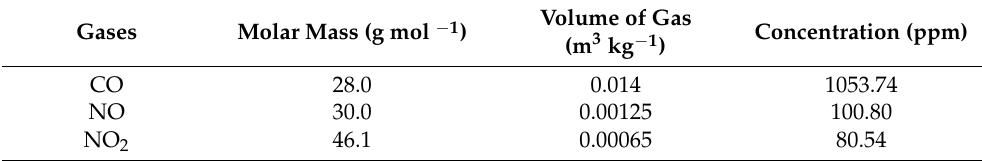
Table 3. Initial concentrations of CO, NO and NO 2 .